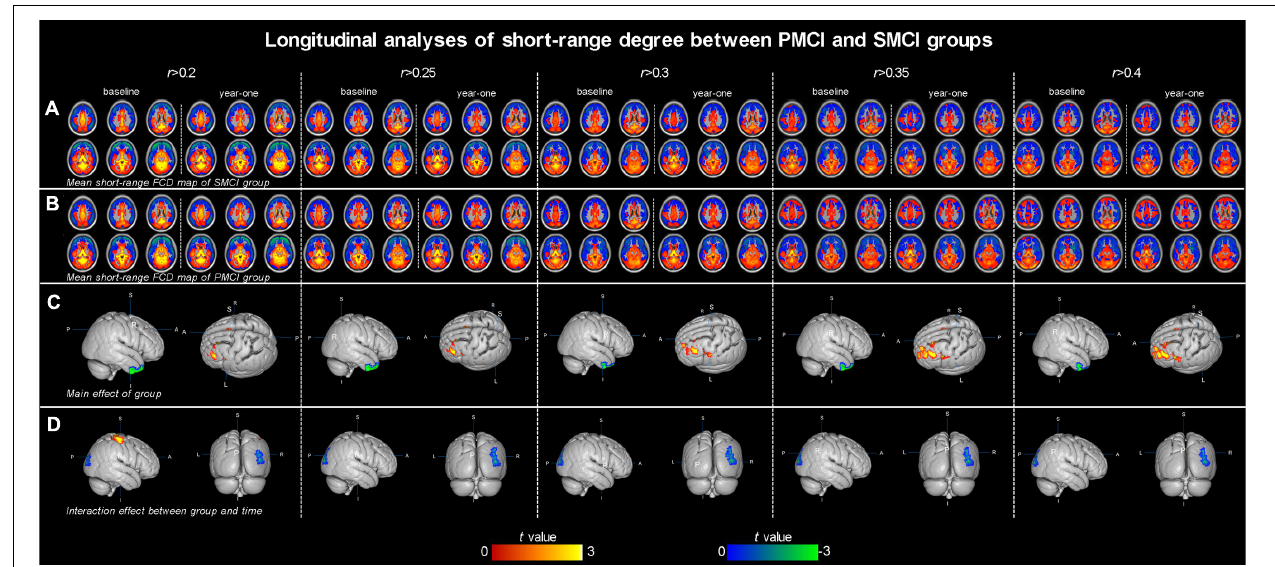
FIGURE 2 | The mean short-range degree maps of progressive mild cognitive impairment (PMCI) group and stable MCI (SMCI) group and the longitudinal analyses results across the correlation threshold range of 0.2–0.4. In row (A,B) , the mean short-range degree maps of SMCI and PMCI groups at baseline and year-one are shown, respectively. In row (C) , the green–blue/red–yellow indicates brain regions with significantly decreased/increased short-range degree in the PMCI group compared with the SMCI group (controlling for the effect of time). In row (D) , the green–blue/red–yellow indicates the brain regions with a significant longitudinal decrease/increase of short-range degree in the PMCI group in 1-year duration compared with SMCI group (Statistical level: p < 0.01 with a minimal cluster size of 54 voxels, which yields an Alphasim correction threshold of p <